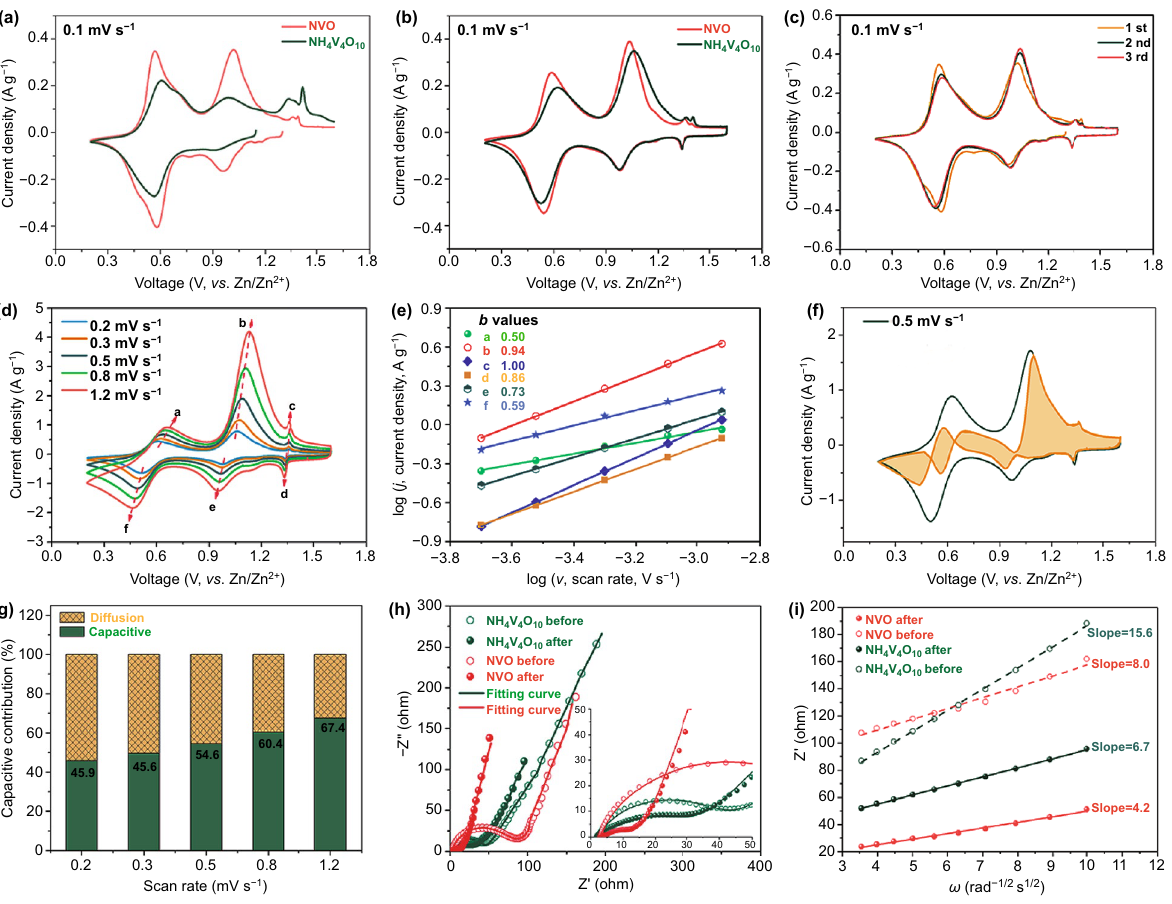
Fig. 3 Electrochemical reaction kinetics. Comparison of a 1 st cycle and b 3 rd cycle CV curves of NH 4 V 4 O 10 and NVO at a scan rate of 0.1 mV s −1 . c CV curves of NVO electrode in the first three cycles, the overlapped curves mean a highly reversible reaction. d CV curves of NVO at different scan rates. e The relationship between peak currents and scan rates. f Capacitive contribution at 0.5 mV s −1 in NVO (54.6%). g The percentages of capacitive and diffusion contributions at different scan rates, increasing from 45.9% to 67.4%. h Nyquist plots of NH 4 V 4 O 10 and NVO before and after CV test. i Relationship between the real part of impedance and low frequencies, smaller slopes of the lines mean fast zinc ion